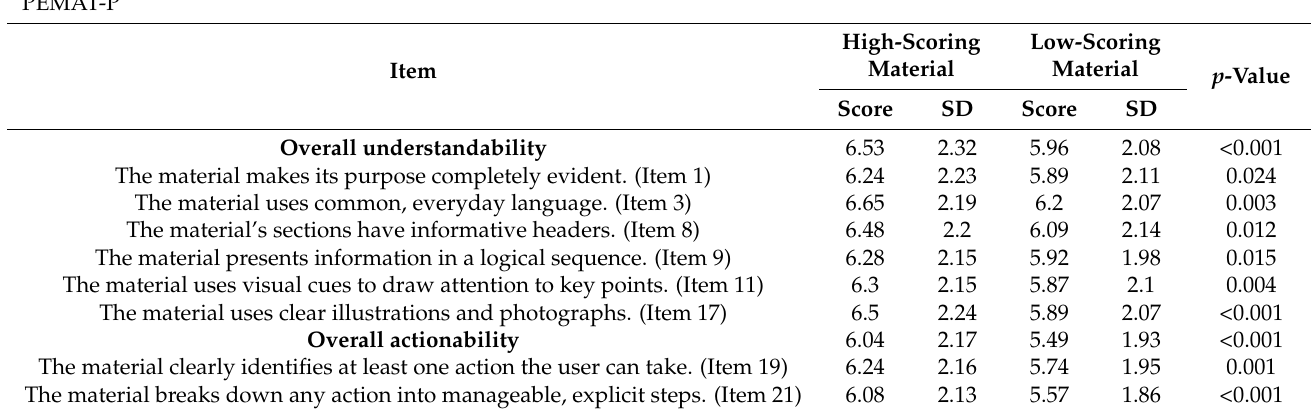
Table 5. Assessment of the material by